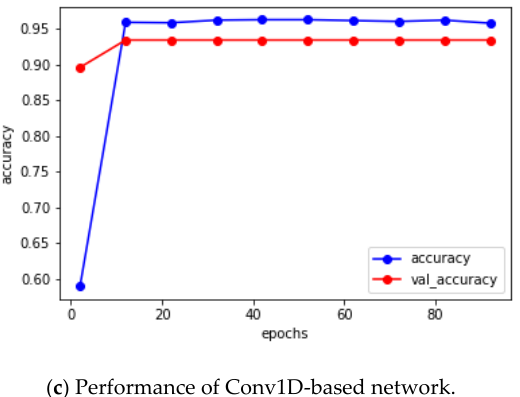
Figure 5. Performance comparison among the different models in terms of accuracy for training, validation, and test dataset. Table 4. The performance of gender detection from Bangla name data. Model Name